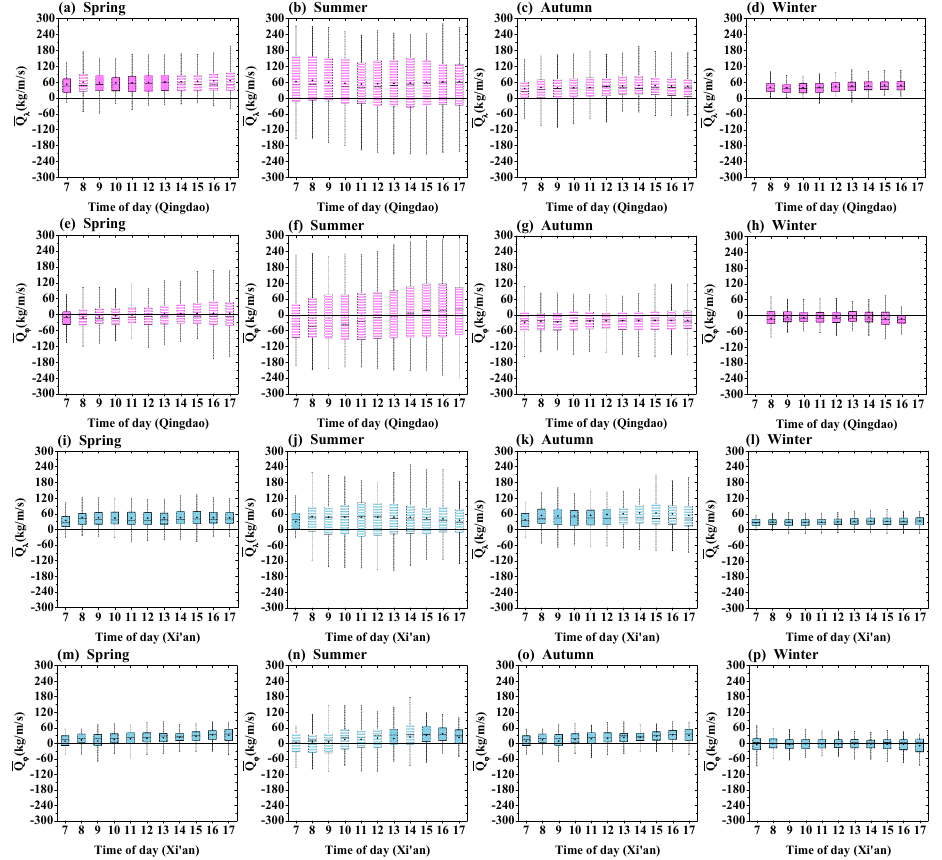
Figure 11. Diurnal variations of the WVFs: the Qingdao zonal fluxes in ( a ) spring, ( b ) summer, ( c ) autumn, and ( d ) winter; the Qingdao meridional fluxes in ( e ) spring, ( f ) summer, ( g ) autumn, and ( h ) winter; the Xi’an zonal fluxes in ( i ) spring, ( j ) summer, ( k ) autumn, and ( l ) winter; the Xi’an meridional fluxes in ( m ) spring, ( n ) summer, ( o ) autumn, and ( p ) winter. Overall, the range of diurnal variation in Xi’an for each season was smaller than that of Qingdao. Because the seasonal and diurnal variations of PW (water vapor VCD) in the two cities are not significantly different (Figures 8 and 9), the water vapor transport flux differences between the two cities were mainly caused by differences in wind direction and wind speed.